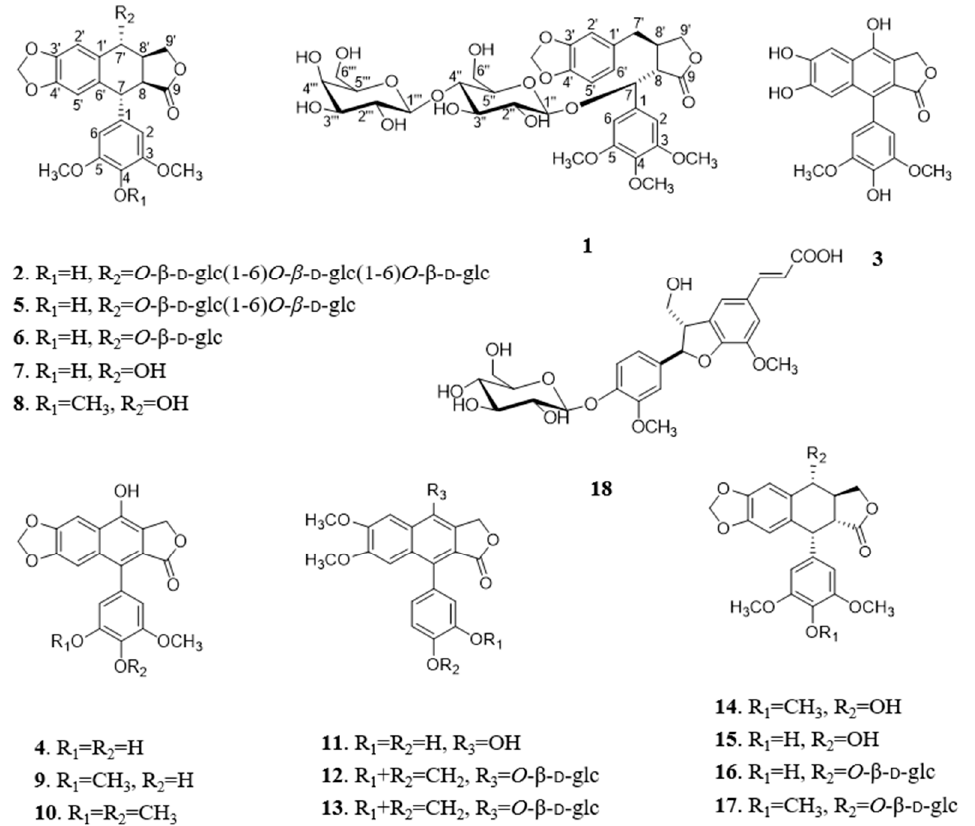
Figure 1. Chemical structures of compounds 1 – 18.